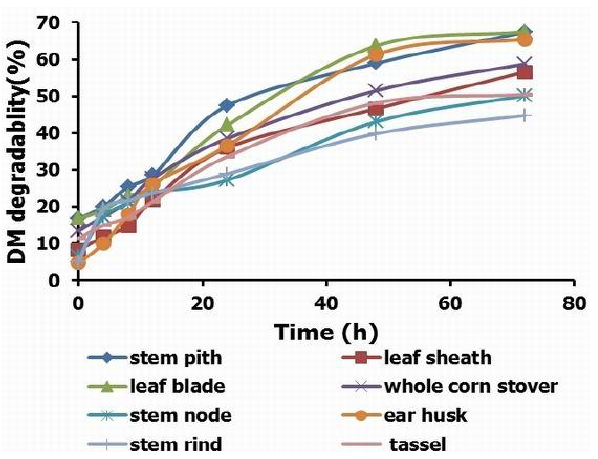
Figure 1. Dry matter degradability of whole corn stover and different morphological fractions during rumen incubation for different periods in dry cows.